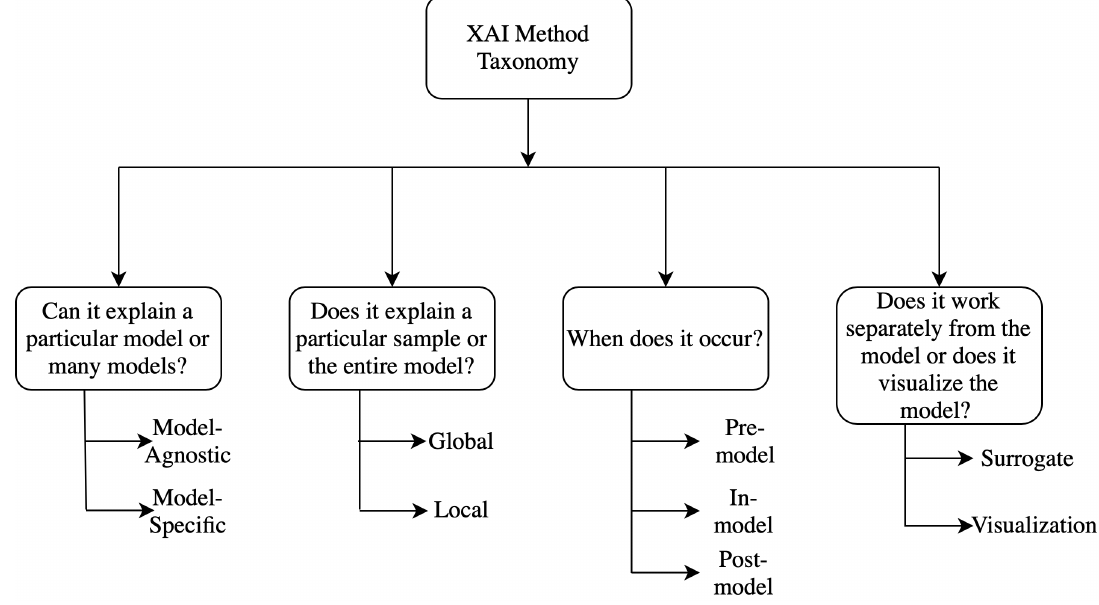
Figure 2. Taxonomy of XAI